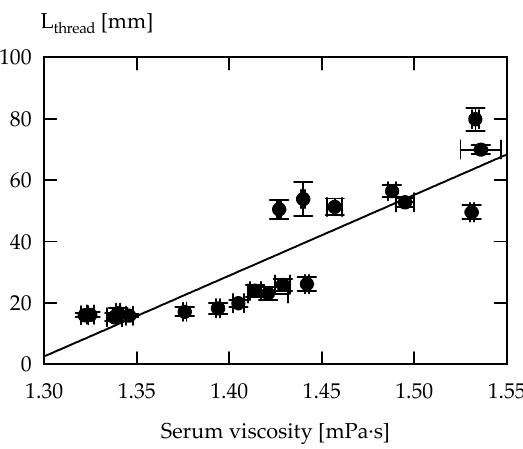
Figure 1. Correlation plot of length of thread (L thread ) vs. serum viscosity of acid gel suspensions from supplemented reconstituted skim milk fermented with S. thermophilus strains ( r = 0.88, p < 0.05).